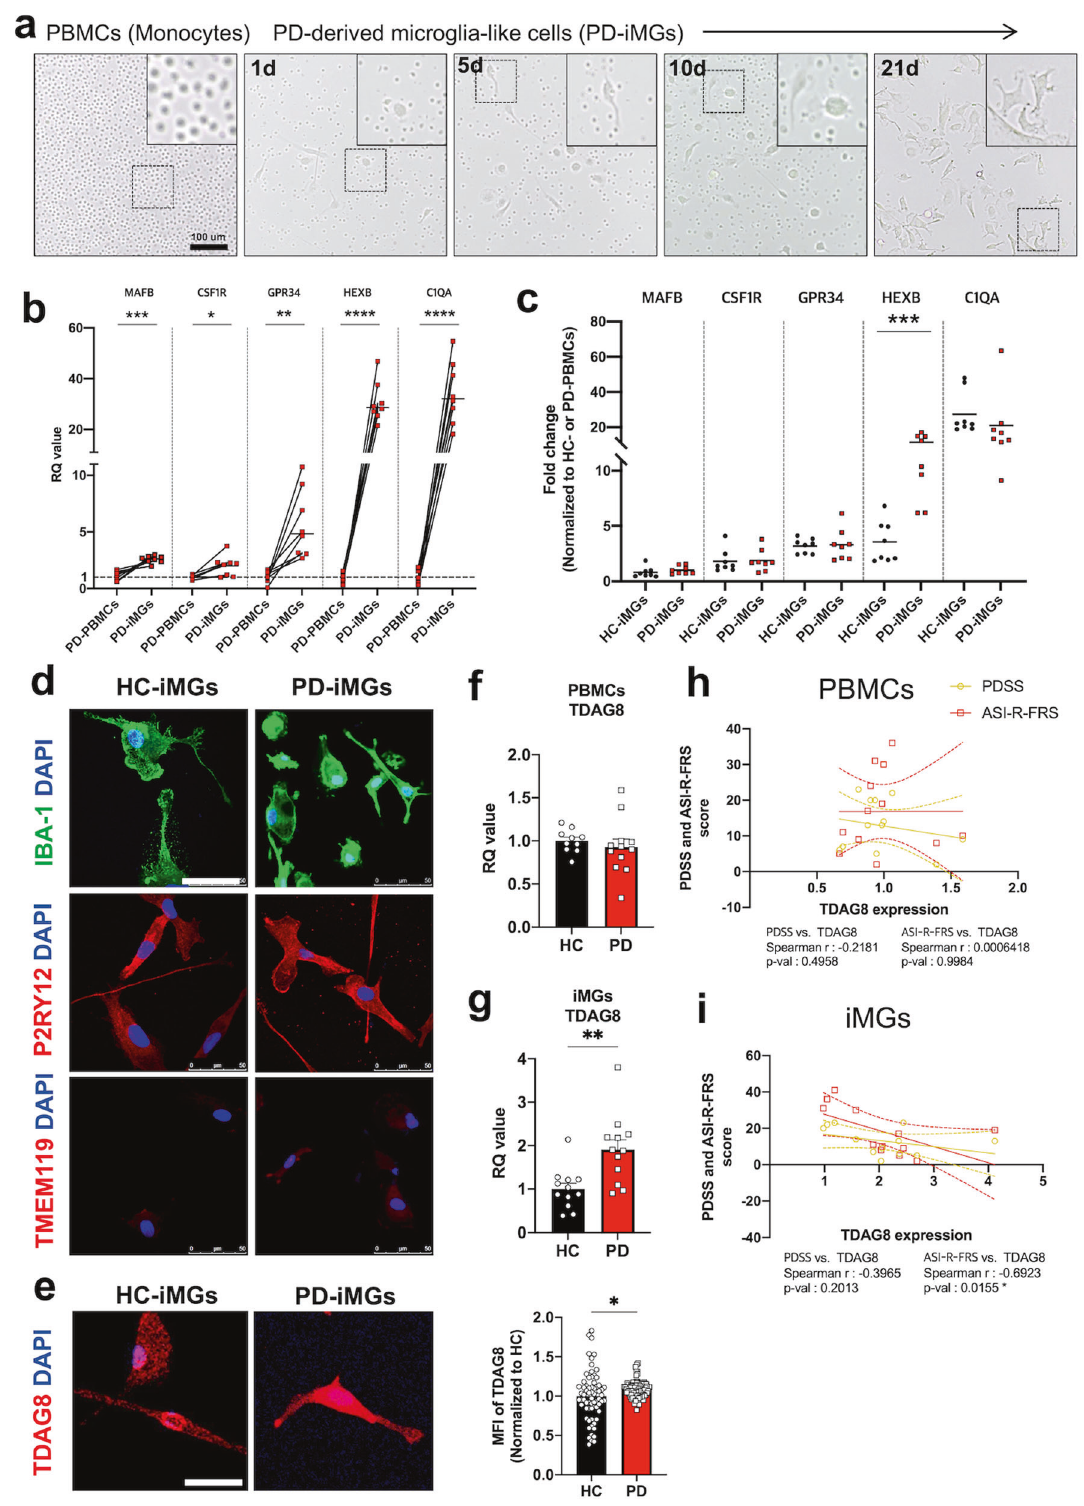
from the peripheral blood of patients with PD and HCs, we isolated PBMCs and cultured them for 21 consecutive days with human IL-34 and GM-CSF, which is essential for microglial survival and differentiation. As shown in Fig. 1a, we observed morpholo- gical changes in PMBCs from small and spherical morphology to enlarged and branched morphology over time. Next,